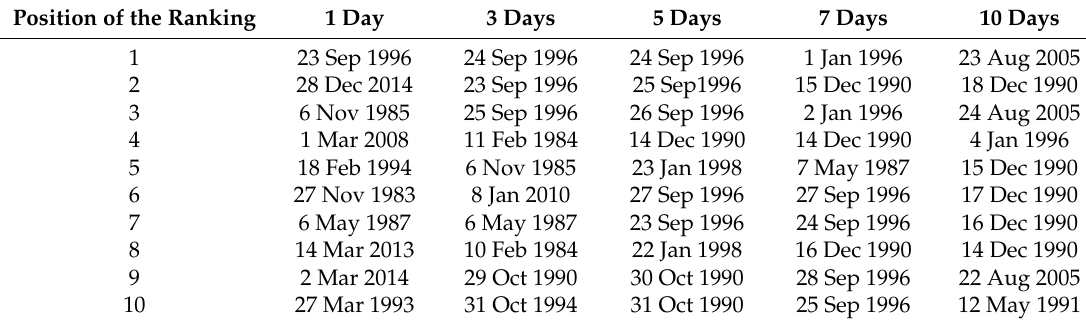
Table 1. List of 10 top extreme precipitation events out of 100 total ranked cases with different durations over the Danube River Basin. The complete list of 100 detected events for all wet-spell durations is shown in the Supplementary Material (Tables